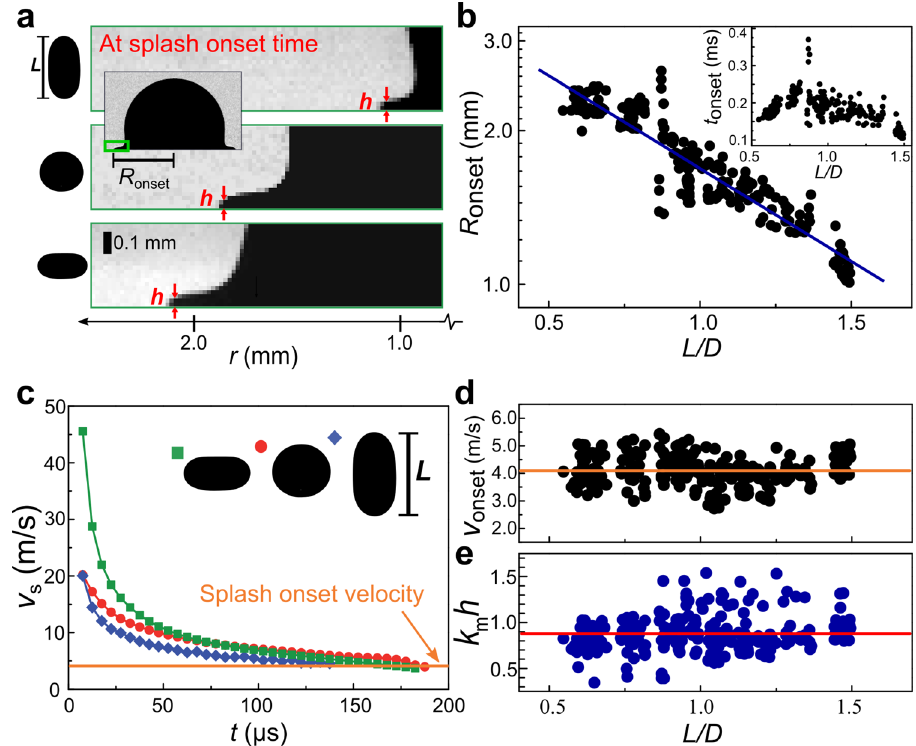
Fig. 3 The onset of splash explained by the Kelvin – Helmholtz instability criterion. a Zoomed-in snapshots at the moment of splash onset for three typical shapes at the same impact velocity, V = 2.9 ± 0.2 m/s. Clearly a longer drop with a larger L has a smaller splash onset location R onset . The red arrows indicate how we measure the liquid sheet thickness, h . The inset shows a zoomed-out image. b The splash onset location, R onset , versus the dimensionless drop length, L/D , with D the diameter of an equivalent sphere. An exponential relation, R onset ∝ exp( − 0.37 L/D ), appears. Inset: The splash onset time t onset also varies signi fi cantly with shape. c Spreading velocity versus time, v s (t) , for the three typical shapes shown in ( a ). Although the three curves initially differ signi fi cantly, their last data points, v onset , are very close. d The splash onset velocities, v onset , for various shapes. They stay close to an average value, 4.1 ± 0.5 m/s, indicated by the horizontal line. e The splash onset data for various shapes agree well with the general criterion: k m h ~1. Here k – Helmholtz (KH) instability in the Knudsen regime 56 . The horizontal line indicates the mean of m is the wave number of the fastest growing mode of Kelvin our data, 0.9. Some large deviations may come from the limited spatial resolution of our camera in the h measurements (see Supplementary Fig.